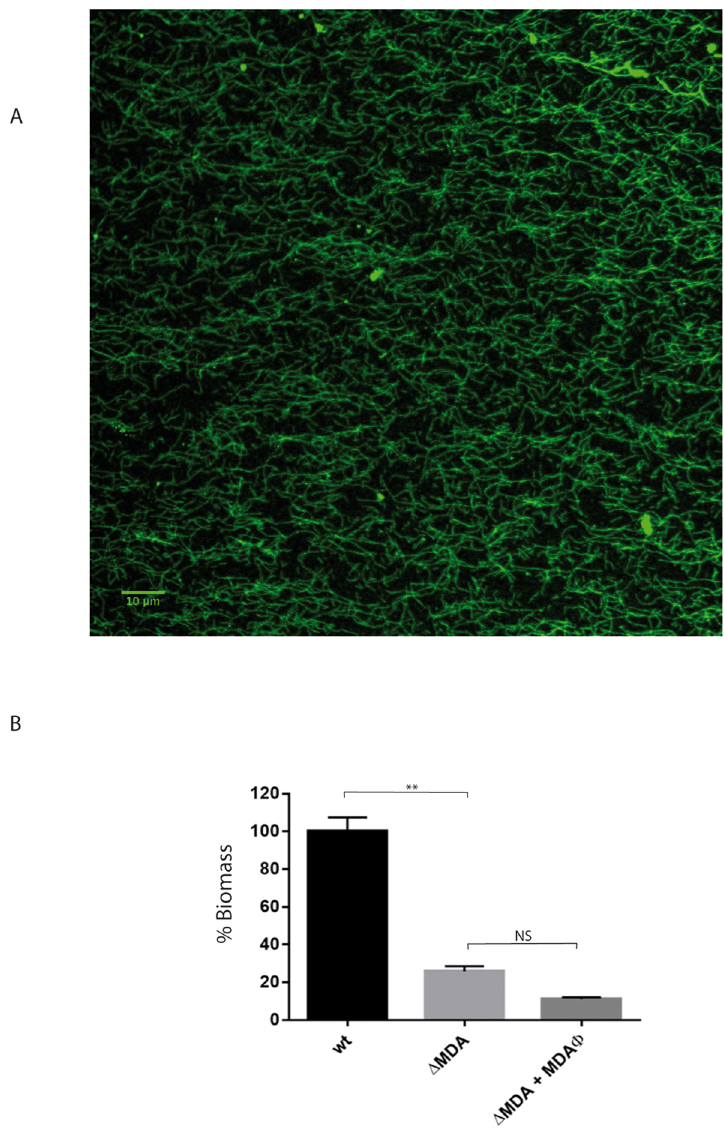
Fig 3. Addition of exogenous bacteriophages. A. Immunofluorescence microscopy performed on the phage preparation using the polyclonal antibody anti-MDAORF4 directed againstthe major capsid protein of MDA. B. Z5463 gfp and Z5463 gfp Δ MDA strains were grown on FaDu epithelialcells for 18 hours under constant flow. In one well, MDA Φ was addedto the growth of the prophagedeletedstrain during the entire experiment at a final concentration of 10 12 particles/mL. At least three independent experiments were performed. The results are normalizedas a percentageof the mean biomassof the wild-typestrain, which was set to 100%. Error bars indicate the standard errors of the mean (SEM). ** p < 0.001 (One-way ANOVA), NS: not significant p value.